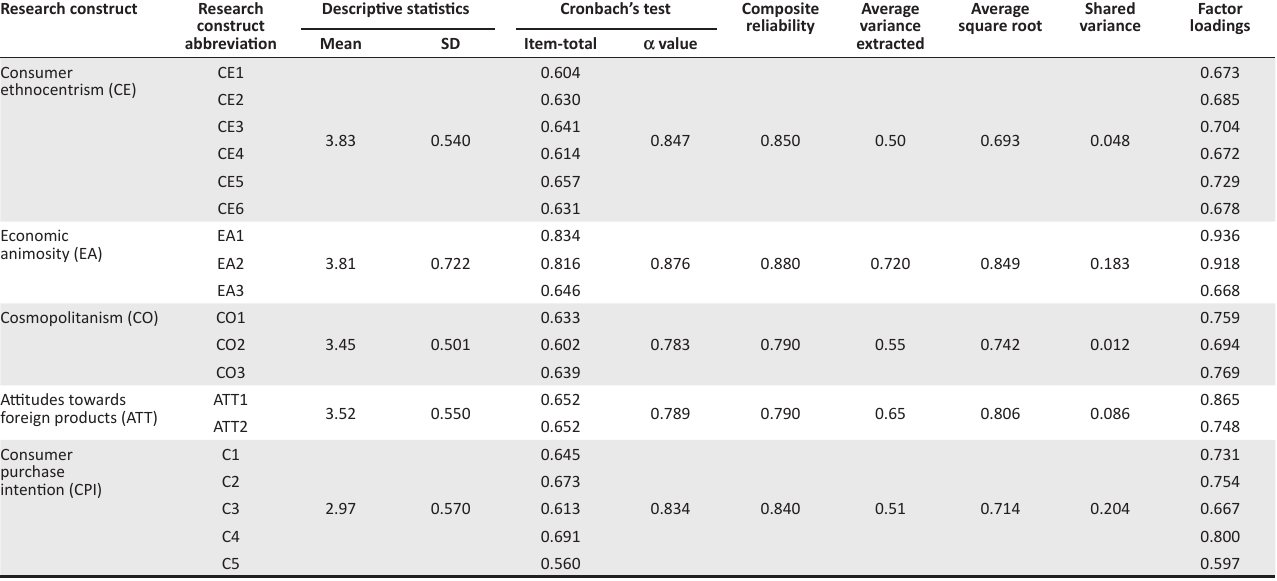
TABLE 1: Reliability and validity